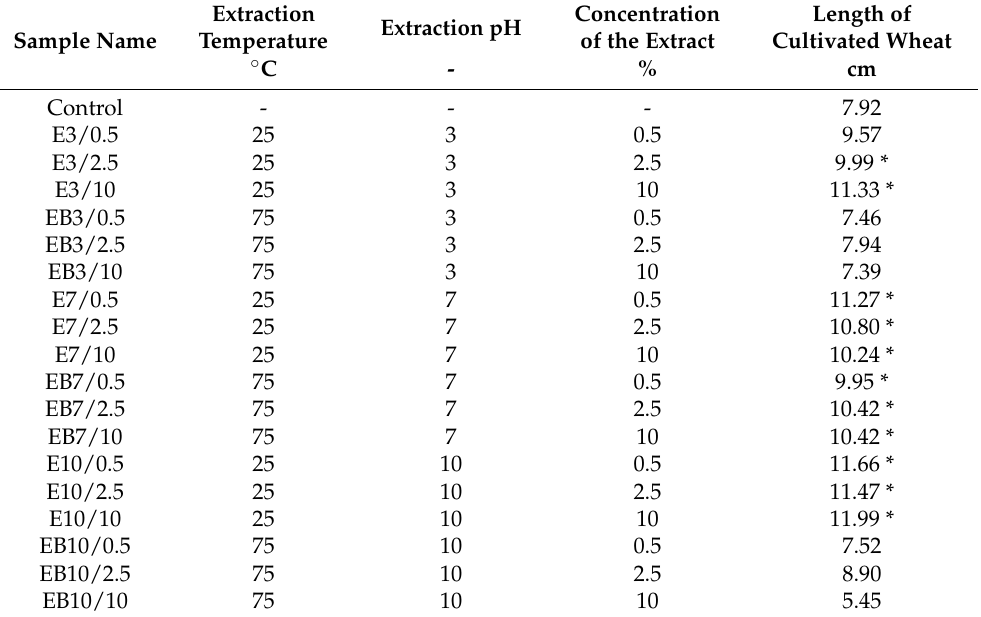
Table 1. The table shows the length of the green part of cultivated wheat treated with the fungal extracts. Index *—indicates the presence of statistically significant differences between the control and tested